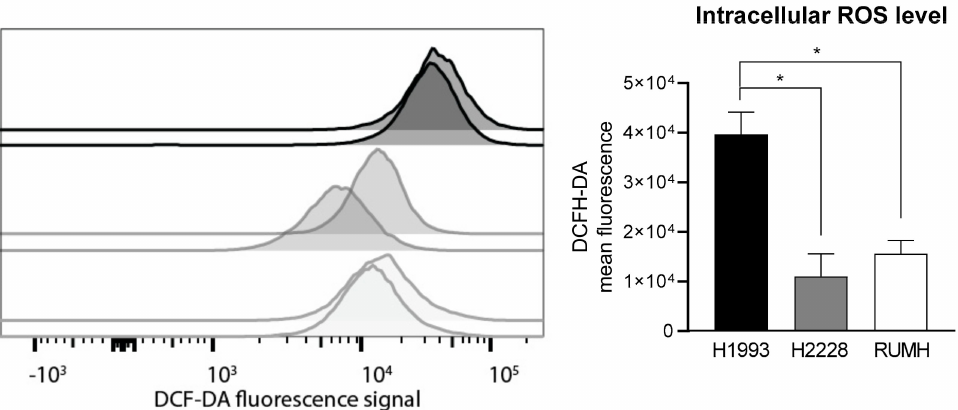
Figure 5. Intracellular ROS levels. Cells were stained with 2 (cid:48) ,7 (cid:48) -dichlorofluorescein diacetate (DCFH-DA) to measure basal ROS levels. Samples were analyzed by flow cytometry and fluorescence signals were quantified using FlowJo and Graphpad Prism software. Bars depict mean ± SD. * p > 0.05, ordinary one-way ANOVA, multiple